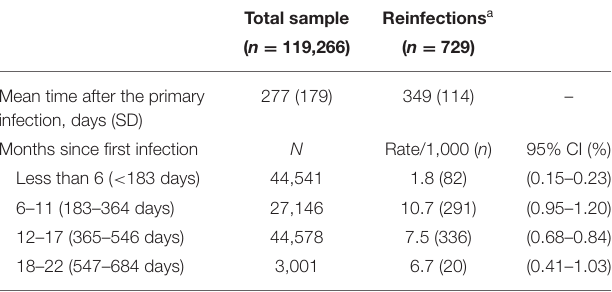
TABLE 1 | Number of SARS-CoV-2 reinfections by the time after first